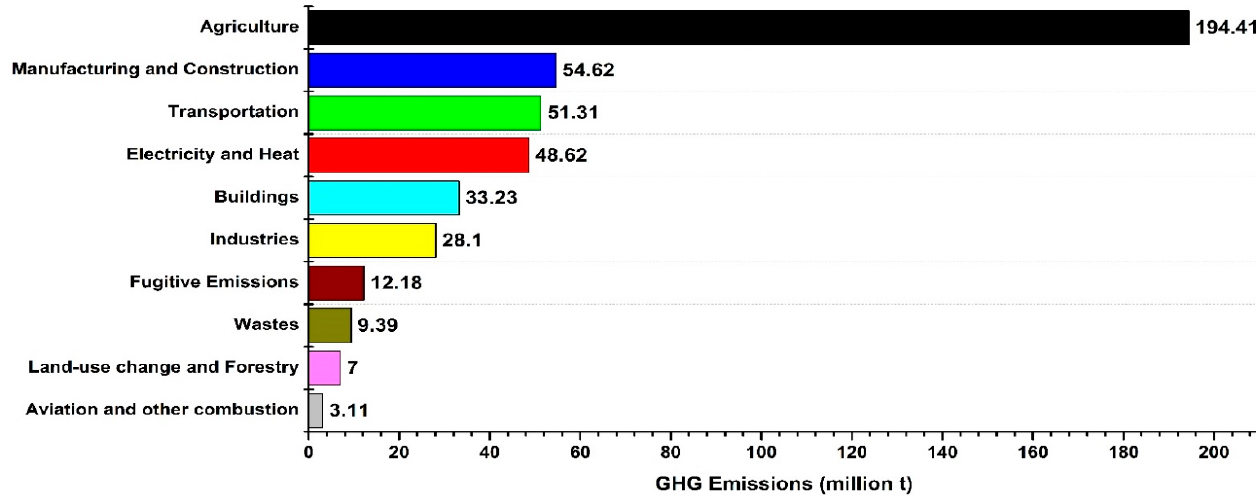
Figure 1 . GHG Emissions by Various Sectors